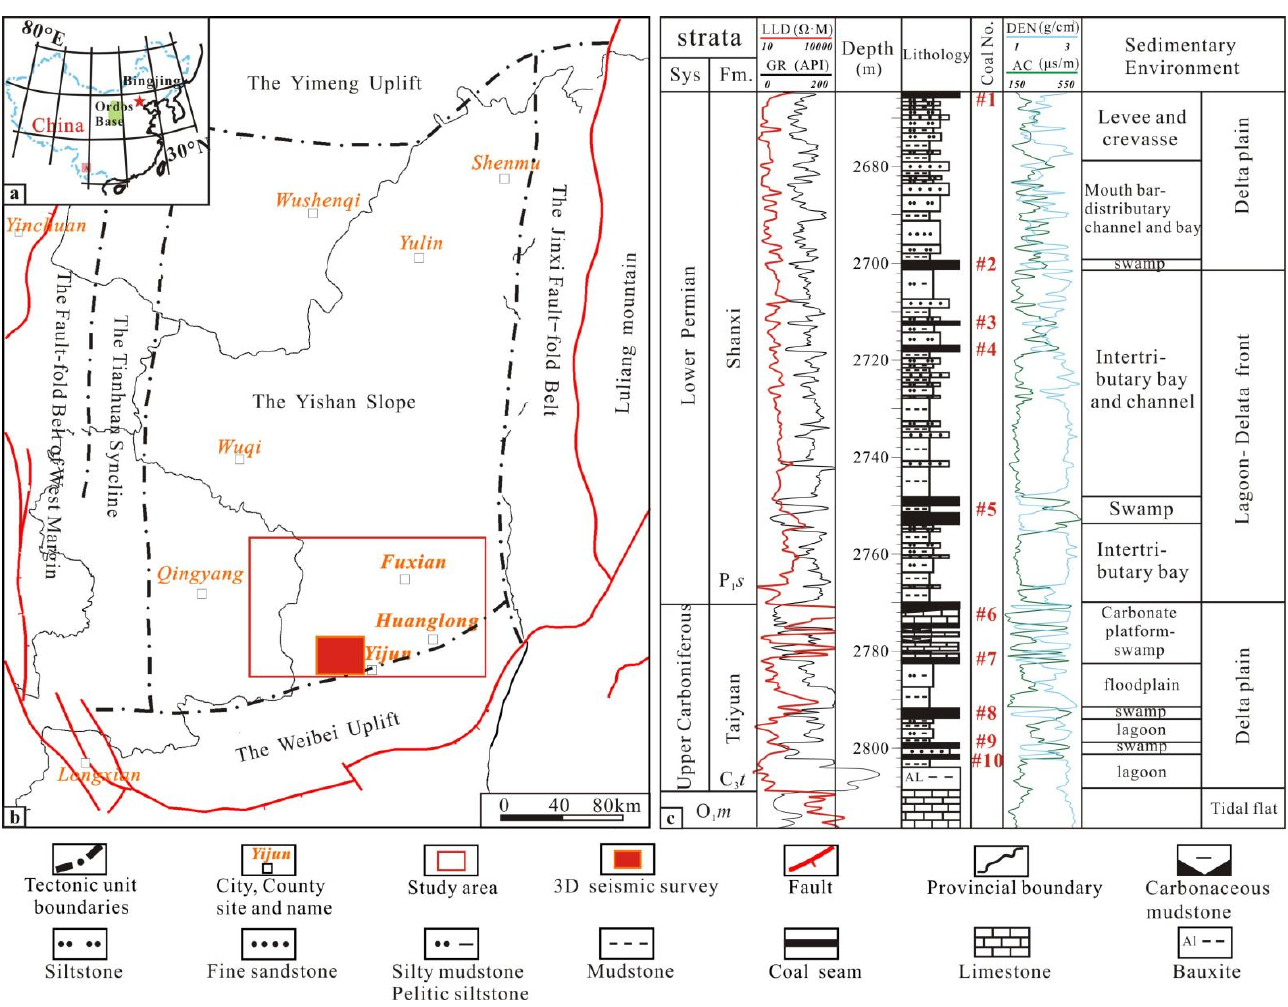
Figure 1. Regional structural units and location of the study area. ( a ) Location of the Ordos Basin; ( b ) Structural units of the Ordos Basin, including the Yimeng uplift, Western thrust belt, Tianhuan depression, Yishan slope, Jinxi flexure belt and Weibei uplift. The study area is located in the southeastern part of the basin. ( c ) Comprehensive stratigraphic histogram from the upper Carboniferous to the lower Permian strata. O 1 m represents the Lower Ordovician Majiagou Formation; LLD stands for deep later log; GR stands for natural gamma ray; AC represents acoustic log; DEN means compensated density.